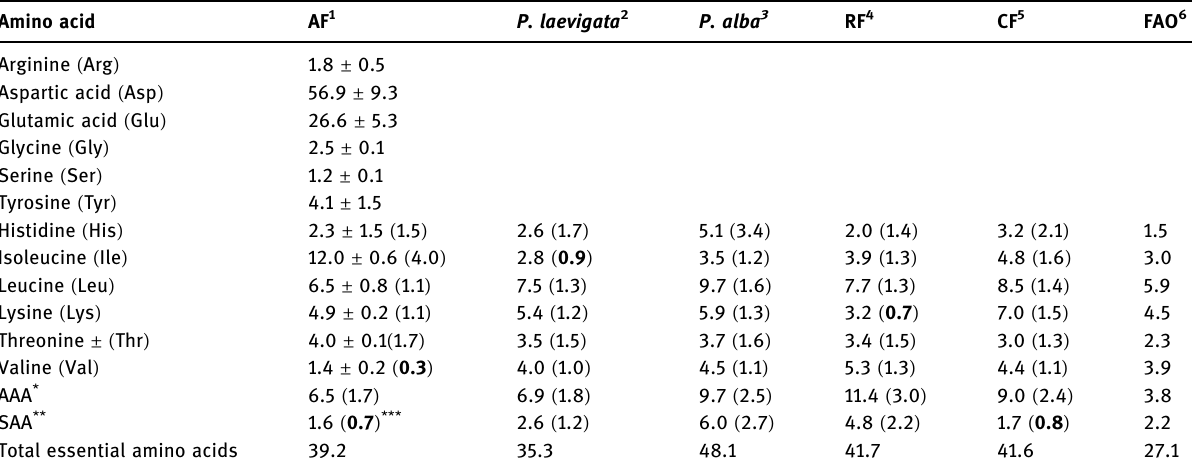
Table 2: Amino acid composition ( g/100 g protein ) of AF ( Algarrobo fl our, P. chilensis ) compared to P. laevigata mesocarp fl our, P. alba germ fl our, rice fl our ( RF ) , chickpea fl our ( CF ) , and FAO